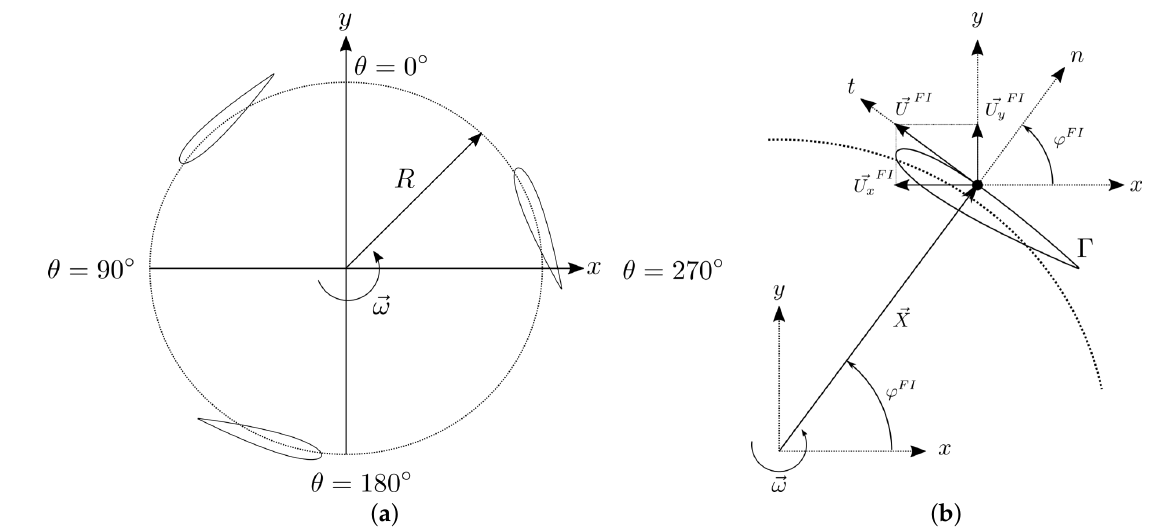
Figure 3. ( a ) Top view of the rotor of a three-blade vertical axis turbine: azimuthal angle variation θ . ( b ) Imposition of the tangential velocity on a Lagrangian point belonging to the blade of a vertical axis turbine.